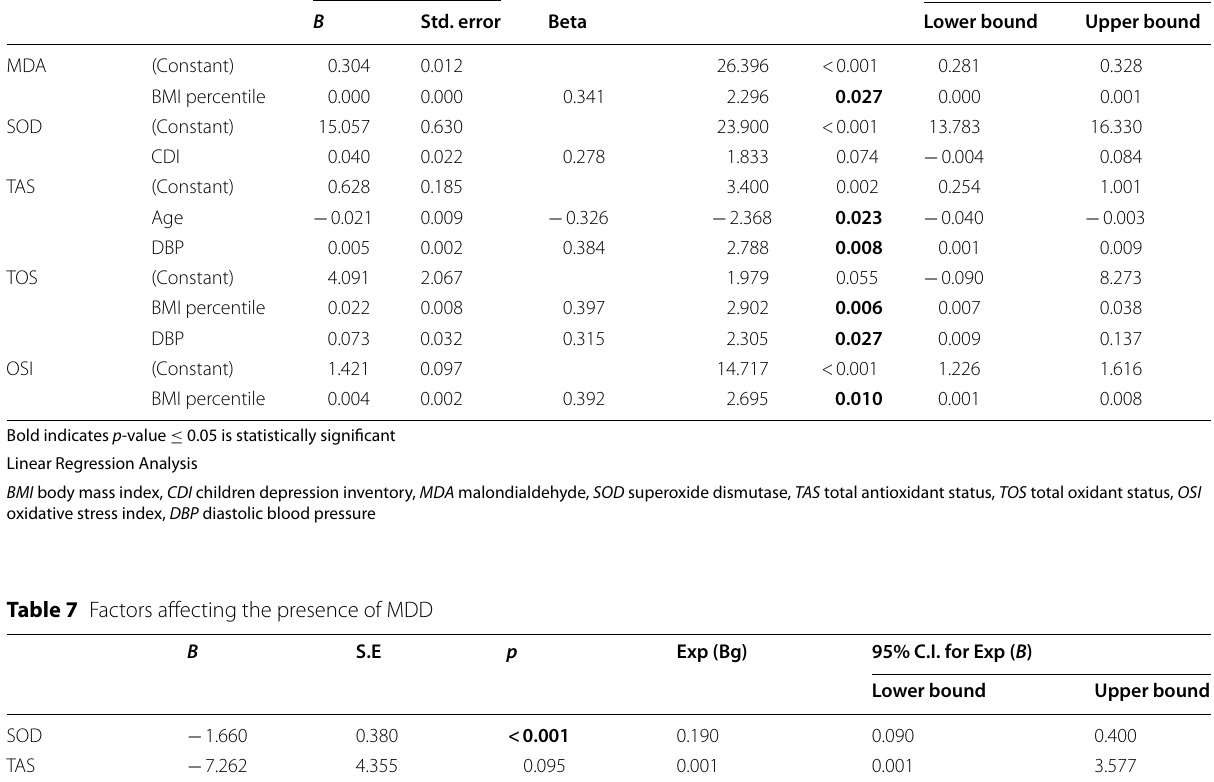
0.05 is statistically significant ≤